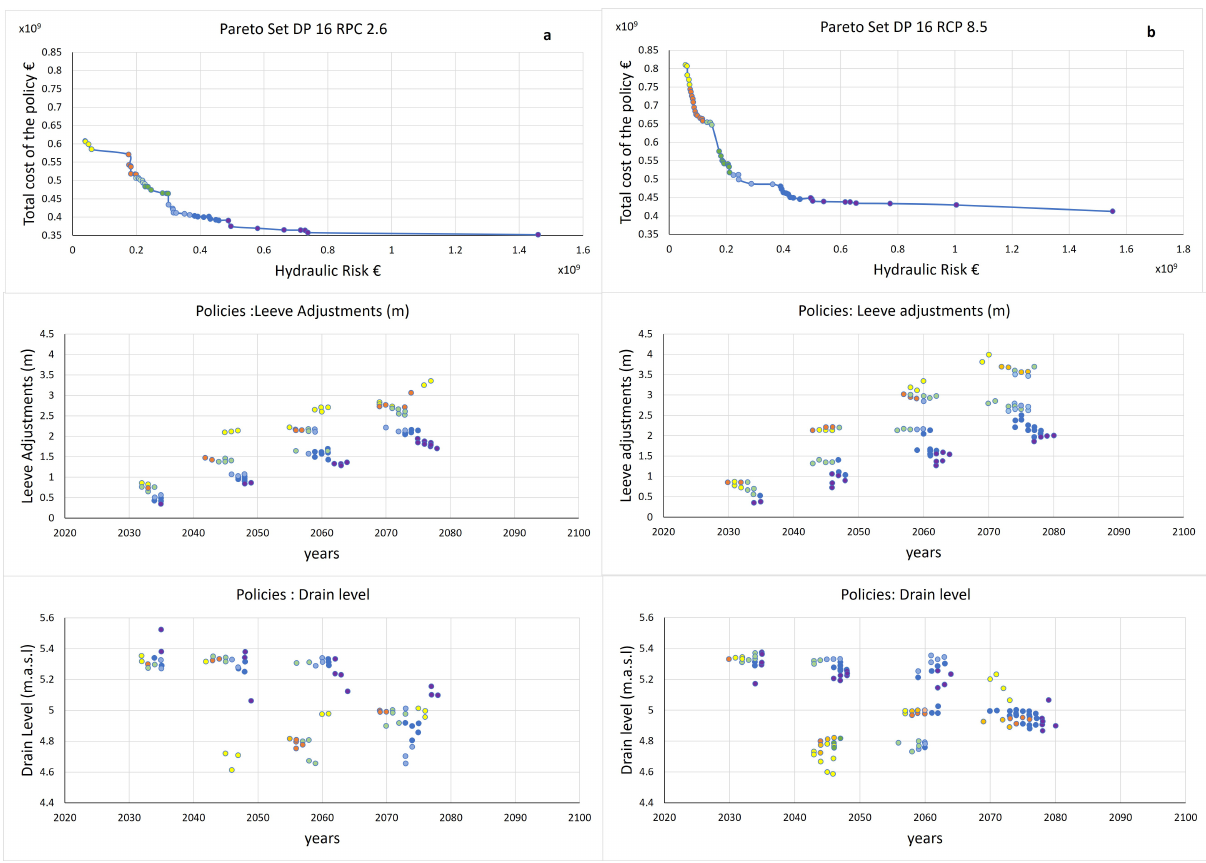
Figure 16. ( a , b ) Size and timing of Flood defence constructions for the Pareto set optimal solutions referred to scenario 3 of Table